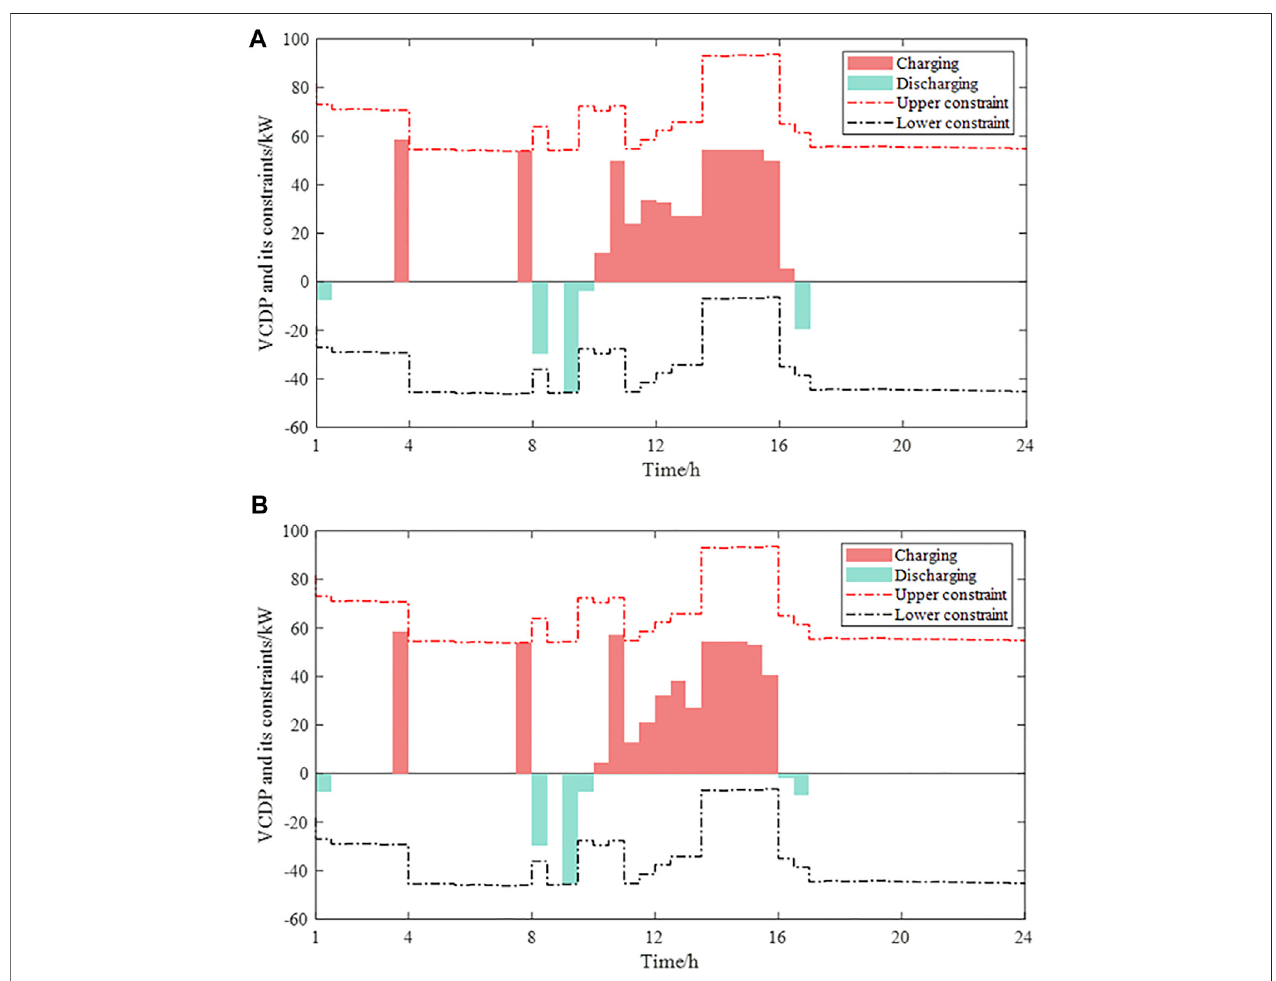
FIGURE 14 | VCDP and its constraints when the optimal scheduling results are f opt- and f opt+ for Scenario I. (A) VCDP and its constraints when the optimal scheduling result is f opt- for Scenario I. (B) VCDP and its constraints when the optimal scheduling result is f opt+ for Scenario I.